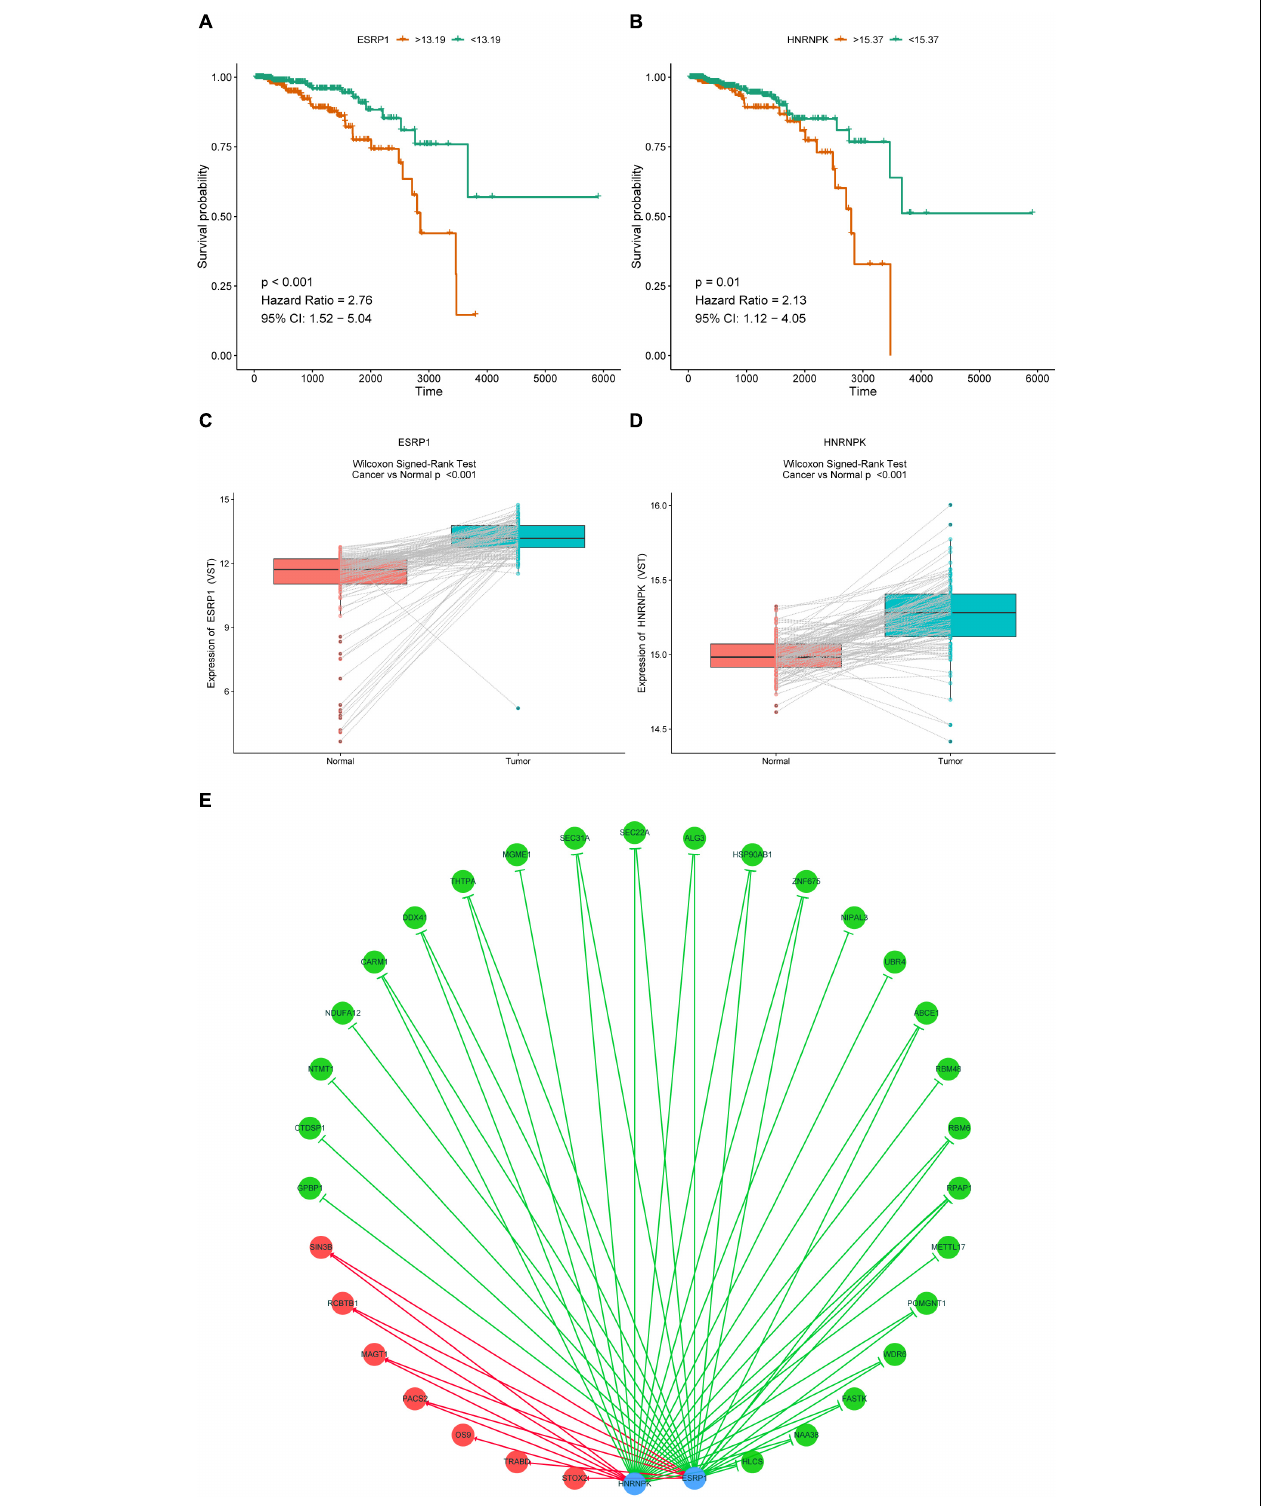
FIGURE 9 | Prognostic SFs and the splicing correlation network in BRCA. (A,B) Survival curves of prognostic SFs. (C,D) The difference of expression values of prognostic SFs between primary BRCA and paired adjacent normal tissues. (E) Construction of SF-AS regulatory network. Expression values of survival-associated SFs (blue dots) were positively (red line) or negatively (green line) correlated with PSI values of AS events included in all types of AS signatures. The protective AS events are indicated by green dots while risky AS events are indicated by red dots.